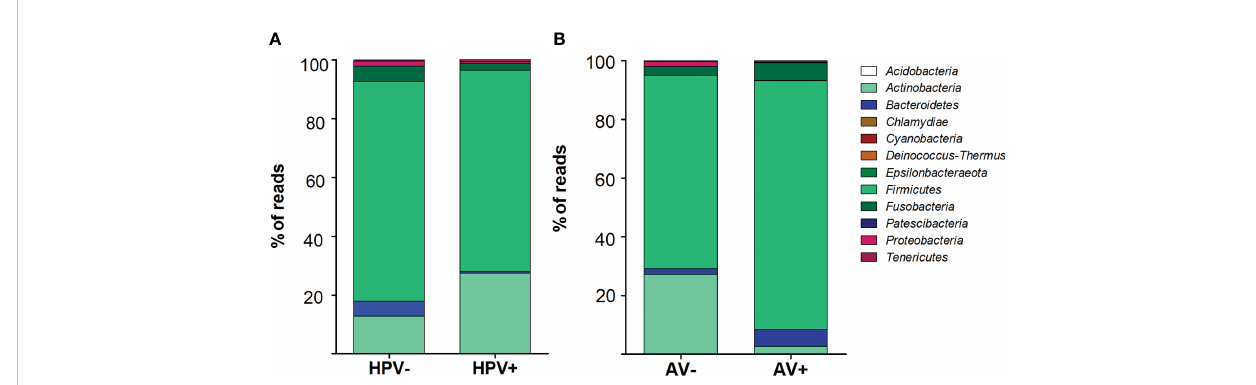
FIGURE 1 Bacterial phyla distribution depending on HPV (A) or Anellovirus (B) status. Stacked vertical bar graphs showing the percentage of total reads found in (A) HPV- and HPV+ women and (B) Anellovirus negative (AV-) and Anellovirus+ (AV+) women. The frequencies of phyla were assessed by chi- square test and were different between groups (p <